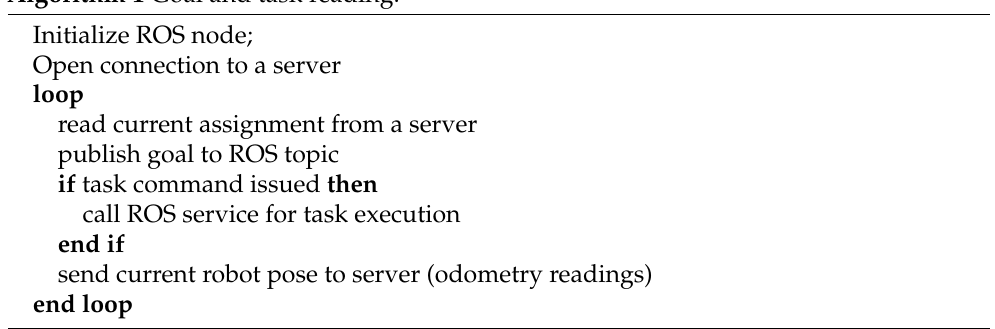
Algorithm 1 Goal and task reading.